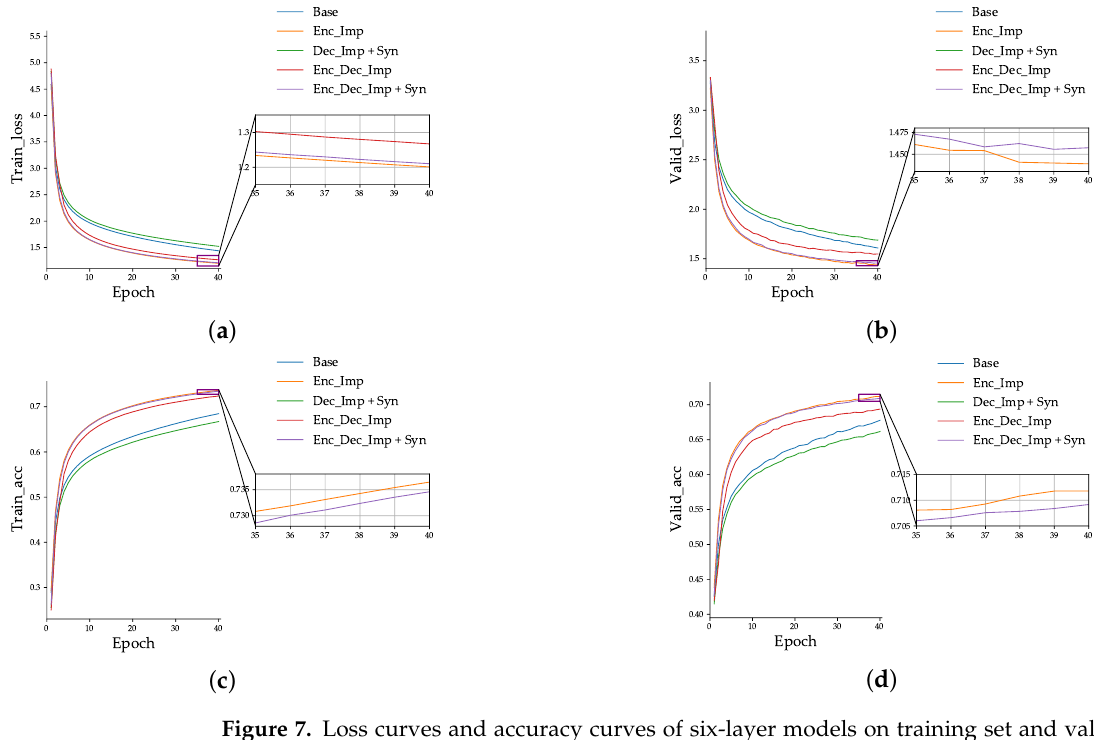
Figure 7. Loss curves and accuracy curves of six-layer models on training set and validation set. ( a ) Training set loss curve. ( b ) Validation set loss curve. ( c ) Training set accuracy curve. ( d ) Validation set accuracy